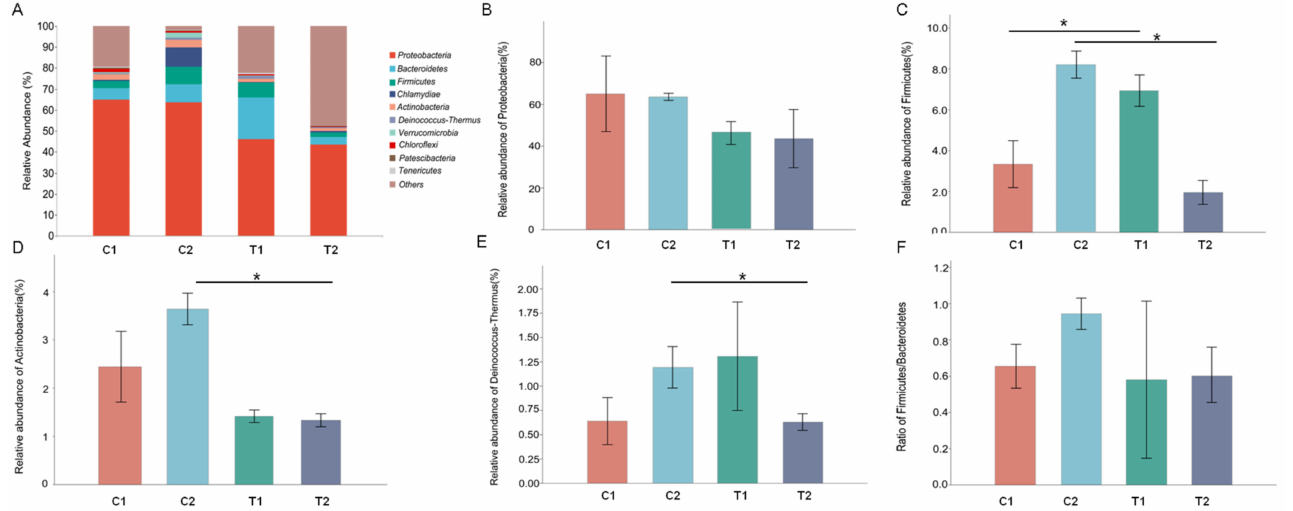
Figure 3. Composition of Cipangopaludina cathayensis intestinal microflora at the phylum level. ( A ) Composition of the intestinal microflora among treatment groups C1 (control treatment; 25 ± 1 ◦ C, day 3), C2 (control treatment; 25 ± 1 ◦ C, day 7), T1 (high-temperature treatment; 32 ± 1 ◦ C, day 3), and T2 (high-temperature treatment; 32 ± 1 ◦ C, day 7); ( B ) relative abundance of phylum Proteobacteria; ( C ) relative abundance of phylum Firmicutes; ( D ) relative abundance of phylum Actinobacteria; ( E ) relative abundance of phylum Deinococcus-Thermus; ( F ) Firmicutes/Bacteroidetes ratio. Asterisks indicate p -values < 0.05.